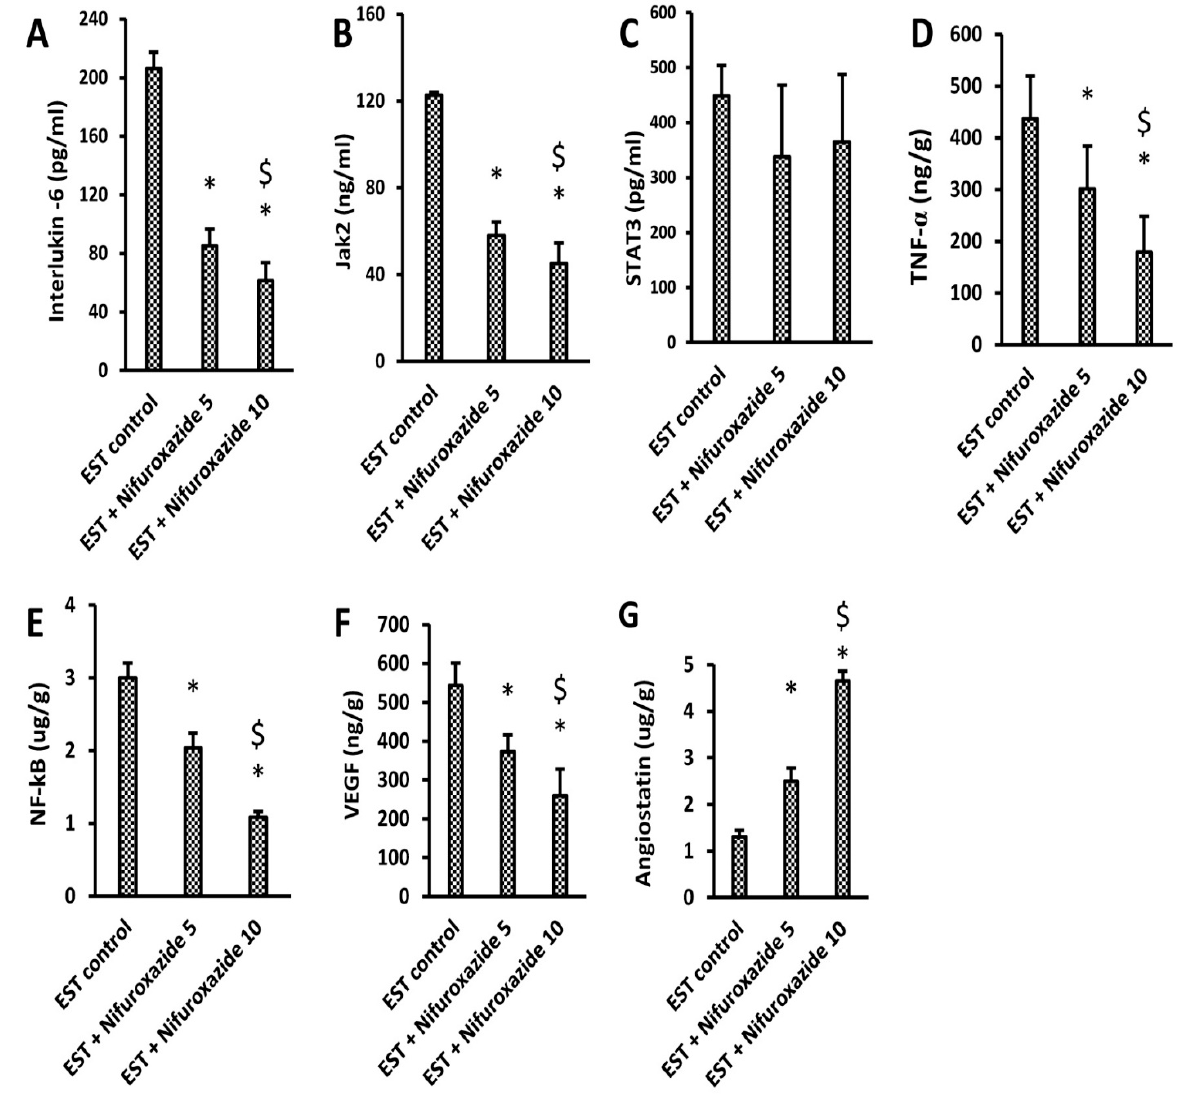
Figure 5. ELISA assays for IL-6, JAK2, STAT3, TNF- α , NF-kB, VEGF, and angiostatin in the solid tumors. ( A ) IL-6, ( B ) JAK2, ( C ) STAT3, ( D ) TNF- α , ( E ) NF-kB, ( F ) VEGF, and ( G ) angiostatin, Column charts demonstrate data as mean ± S.D at P less than 0.05. * Versus the EST control, $ Versus the EST + Nifuroxazide (5 mg/kg) group.